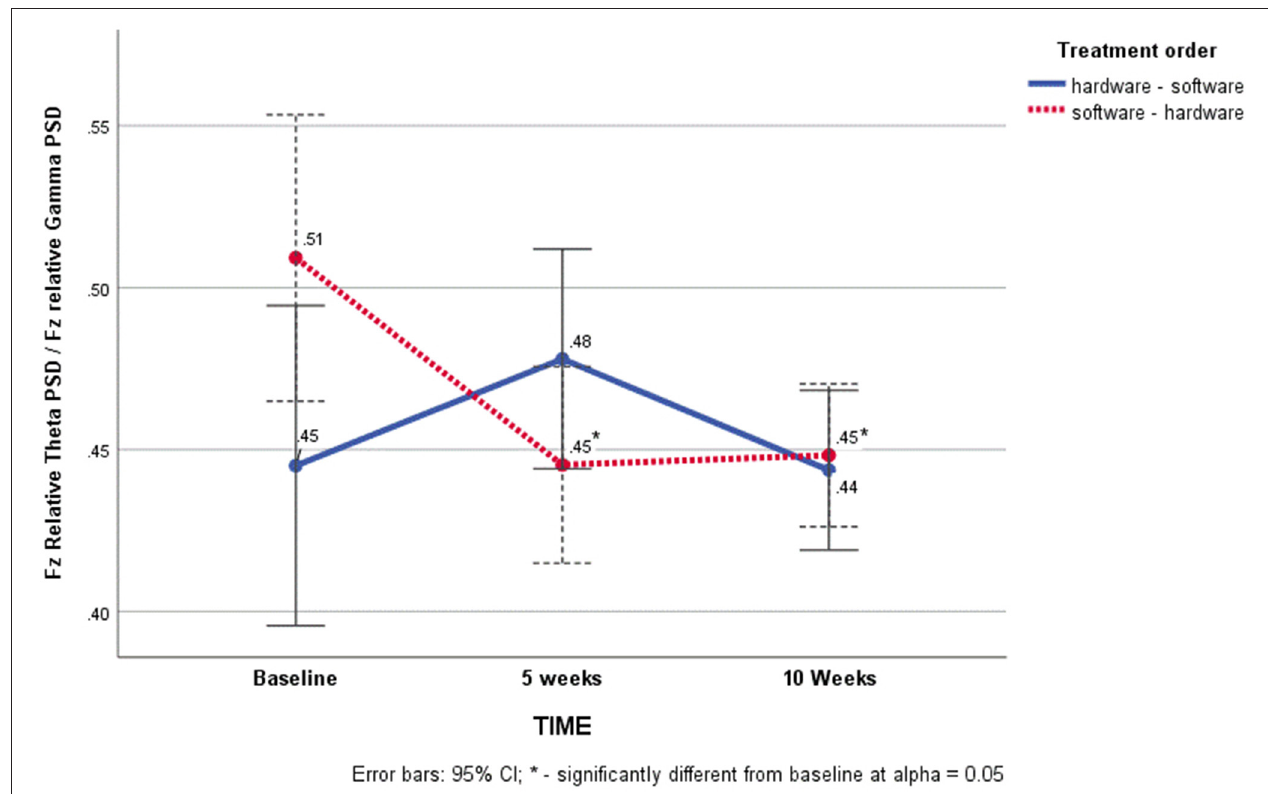
FIGURE 2 | Changes in Short-term Memory Load Index on the Near-Far Quickness Task as a function of time and treatment